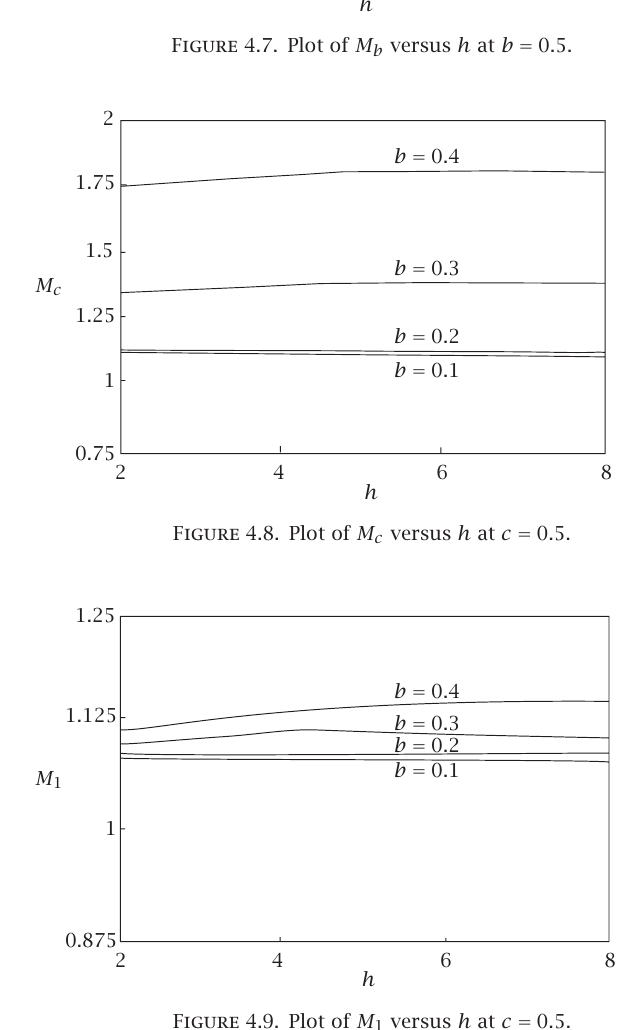
1 versus h at c